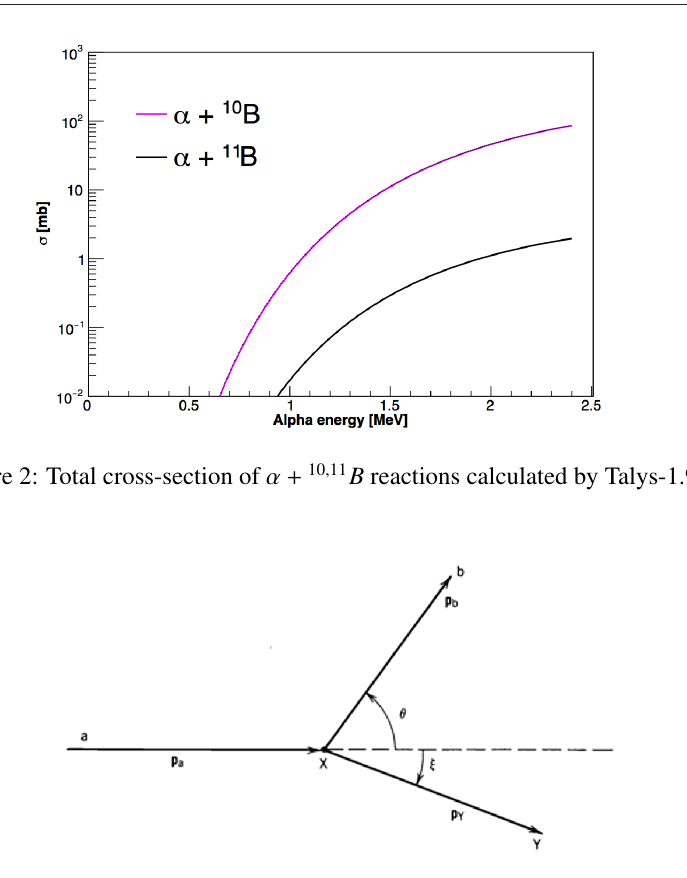
Figure 3: Basic reaction geometry for a + X → b +